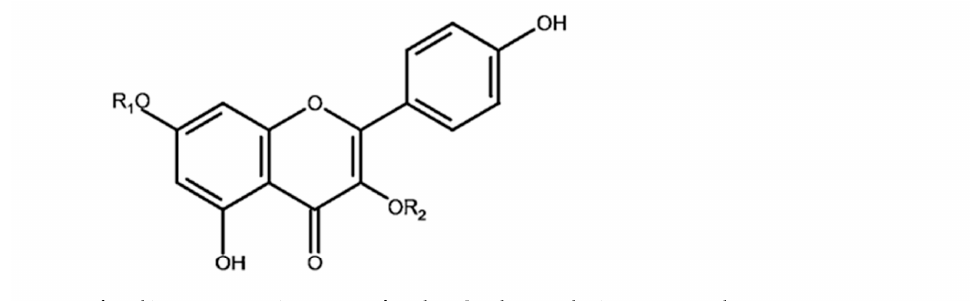
Figure 1. Chemical structure of kaempferol and commonly detected glycosides (adapted from [27]) .